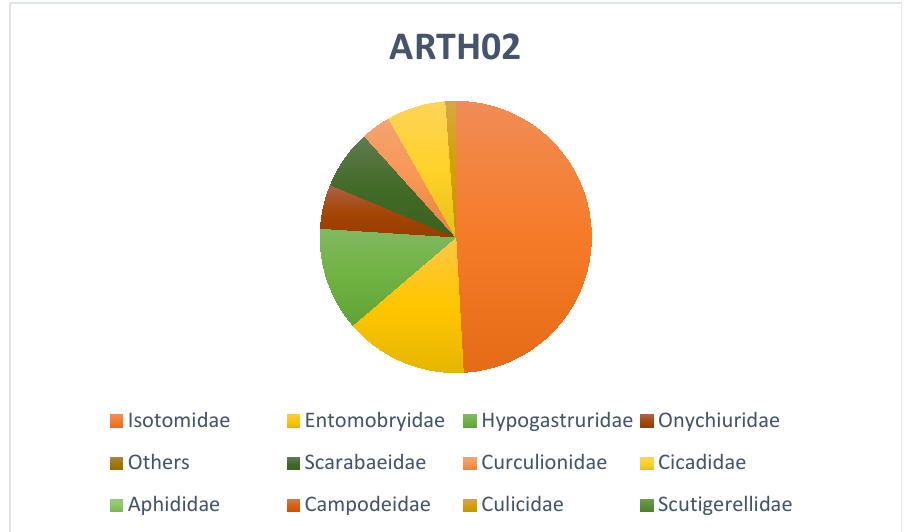
Figure 1. Representation of the Arthropods community read abundance detected with the primer ARTH02.